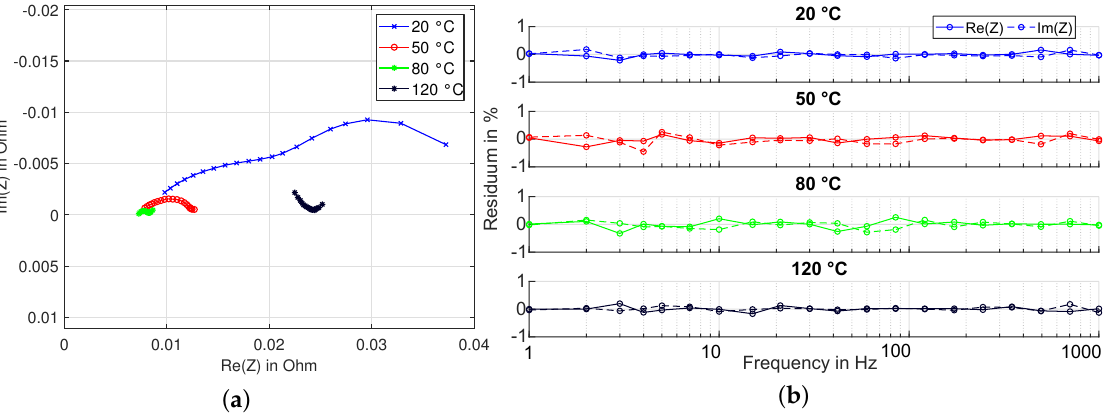
Figure 10. Left ( a ): Experiment HT1 - Nyquist plot of the complex impedance in the range from 1Hz to 1kHz of the cell heated at 50% state of charge in the calorimeter. Right ( b ): Calculated Kramers-Kronig residuals of impedance spectra, showing that stationarity conditions are